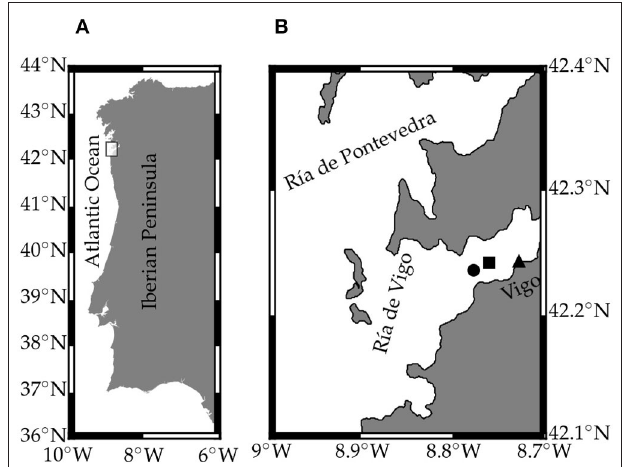
FIGURE 1 | Map of the study area showing (A) the Iberian Peninsula and (B) the Ría de Vigo B). The circle indicates the EF sampling station (8.778 ◦ W 42.235 ◦ N), the square the ADCP position (8.761 ◦ W 42.241 ◦ N) and the triangle the Porto station (8.728 ◦ W 42.242 ◦